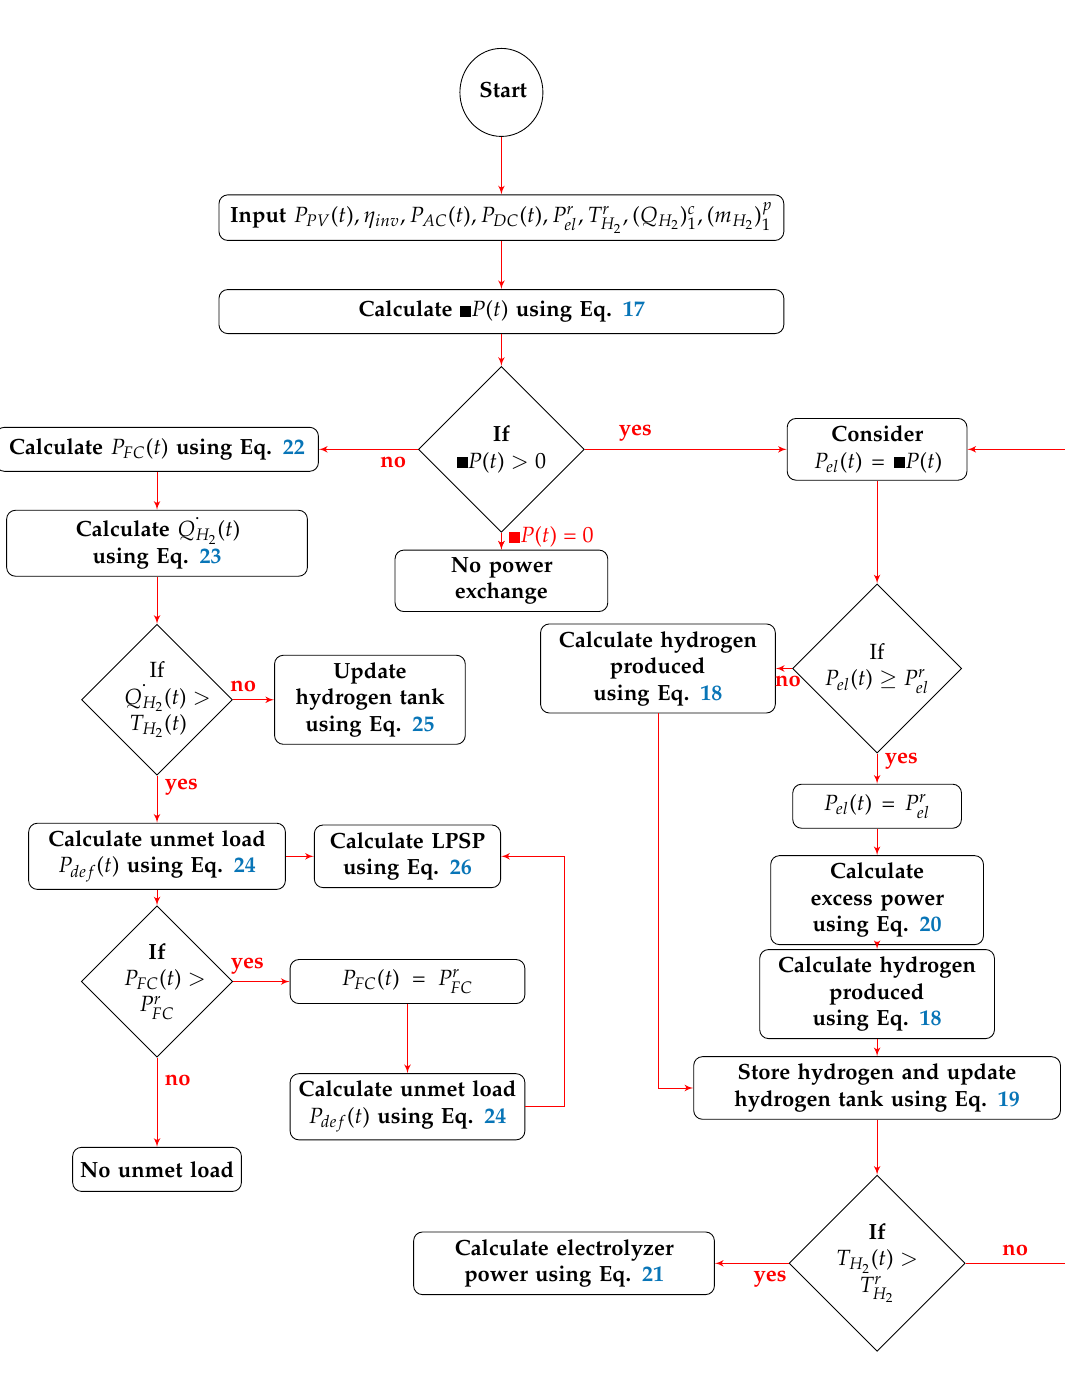
Figure 2. Flow chart for energy management of the proposed system.